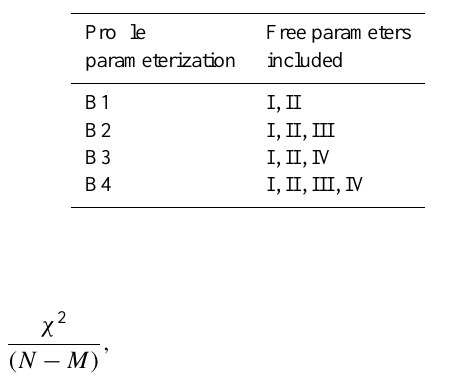
Table 2. Retrieval with method B is performed for different com- binations of free parameters which describe the profile shape. See also Fig.